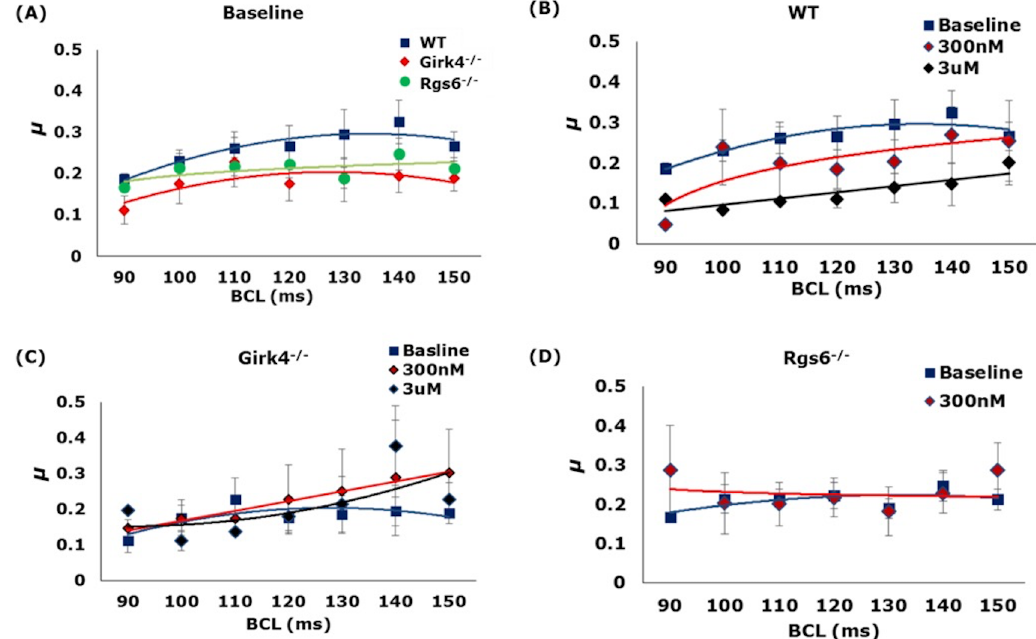
Fig 5. The effect of GIRK4 and RGS6 ablation on APD heterogeneity, μ . (A) Average APD heterogeneity, μ , as a function of BCL in WT, Girk4 -/- , and Rgs6 -/- hearts. (B-D) The effect of CCh on μ at different BCL in WT, Girk4 -/- , and Rgs6 -/- hearts. n = 8, 5, 8 for WT, Rgs6 -/- , and Girk4 -/- respectively. Statistics performed using 1-way